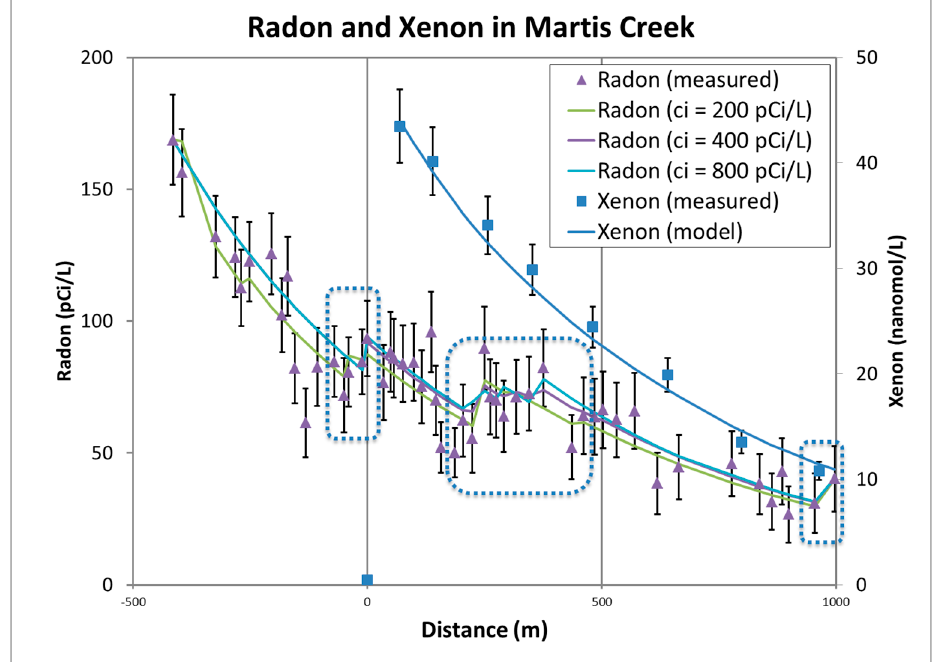
Figure 3. Measured 222 Rn activities (purple triangles) and Xe concentrations (blue squares) in the study reach are shown along with the predicted model values for 222 Rn for different values of the groundwater 222 Rn concentration c i (purple, green, and blue lines) and Xe (blue line). Dashed rectangles highlight stretches of Martis Creek where groundwater inflow is detected. Distance 0 shows the tracer introduction location (MC00 in Table 1), distance 500 m is the approximate location of MC23 and distance 1000 m is the approximate location of MC34 (Table 1).